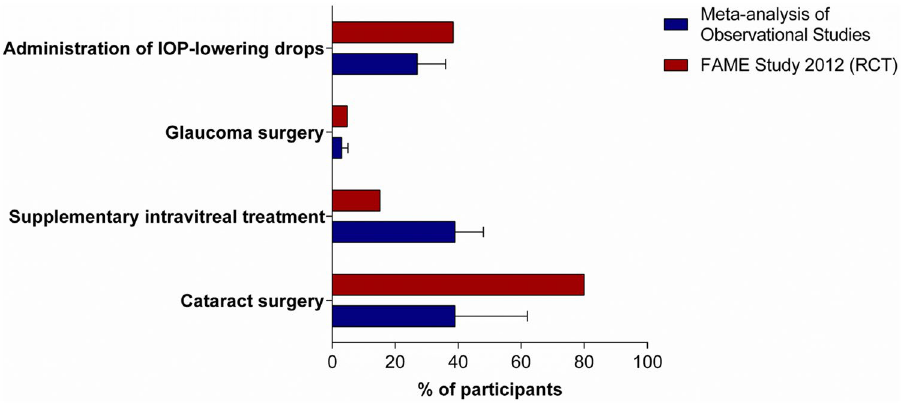
Figure 6. Pooled estimates of rates of eyes requiring cataract surgery, supplementary intravitreal treatment, intraocular pressure (IOP) lowering drops, glaucoma surgery. Blue histograms refer to pooled estimates from real-world studies; red histograms refer to rates from the 36-month FAME